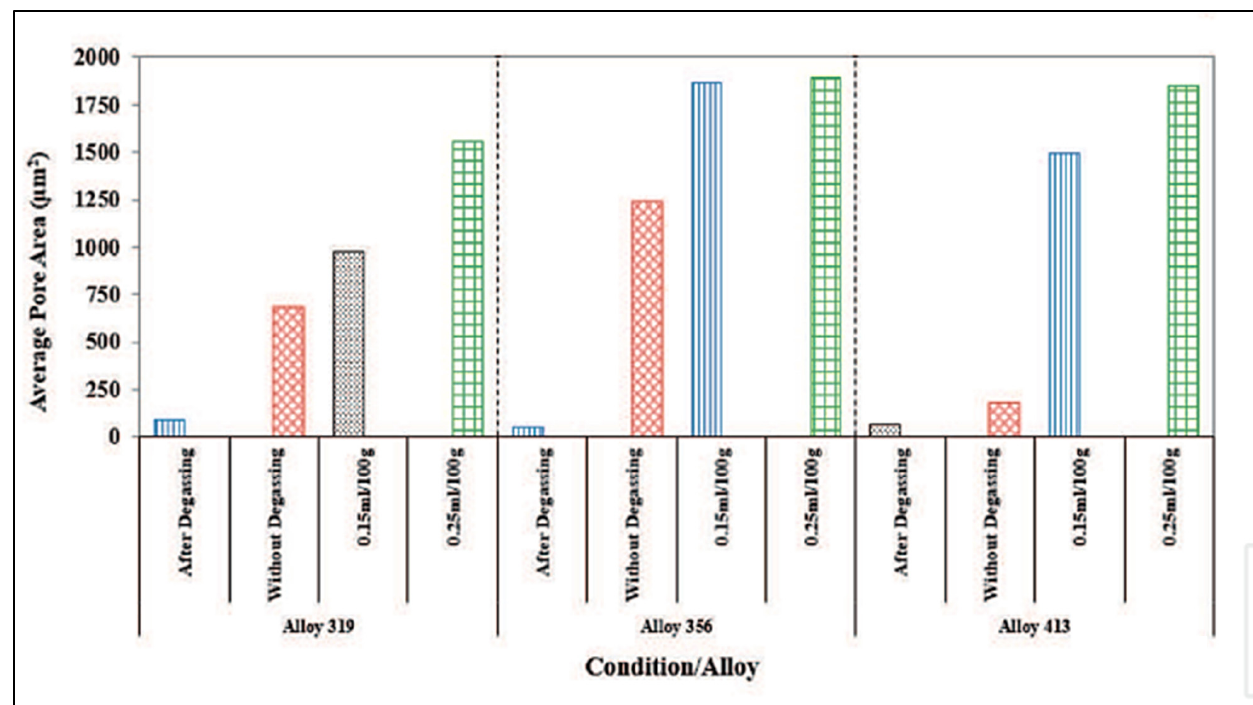
Figure 6. Temperature–time curves obtained at different distance from the chill end. Thermocouples were placed along the centerline of the mold through the refractory block into the cavity.